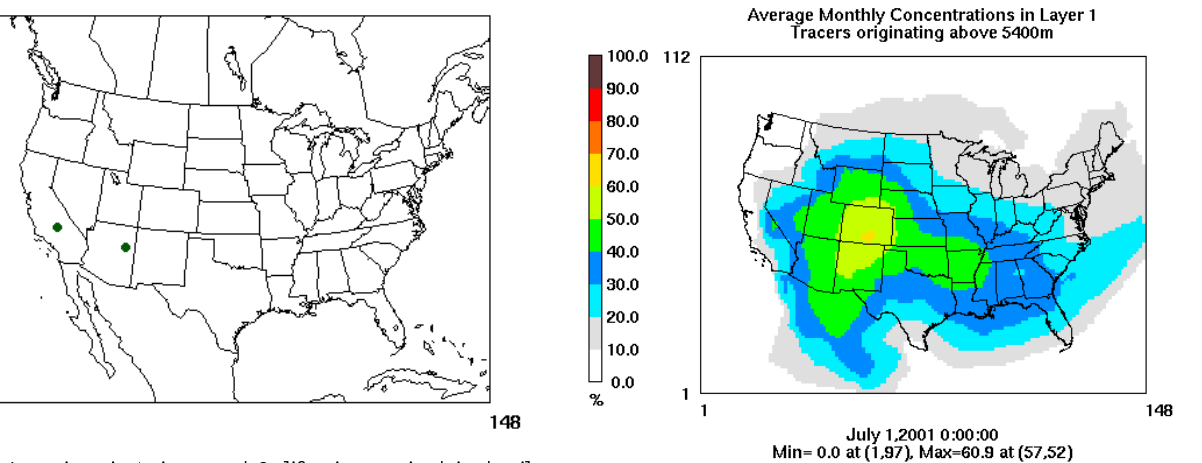
Fig. 10. Locations in Arizona and California examined in detail Fig. 11.